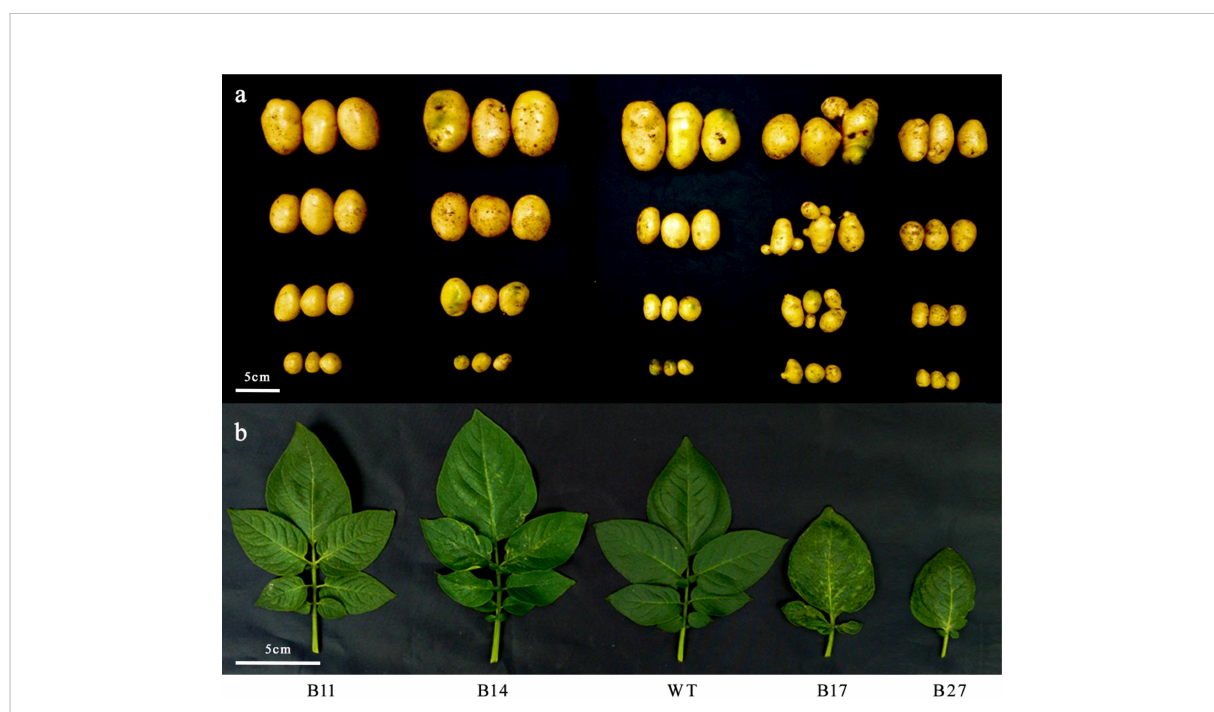
FIGURE 1 Phenotype of the second-generation plants of tuber propagation. Comparison of tuber morphology (A) and leaf (B) between transgenic and wild